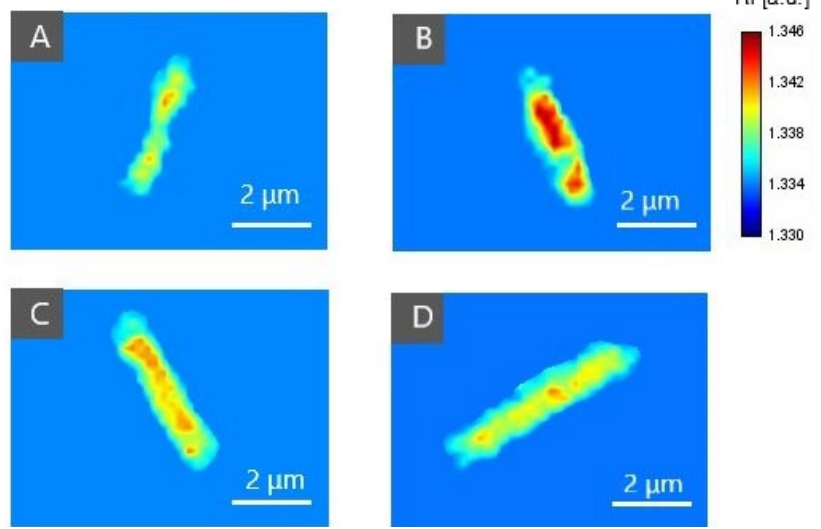
Figure 4. The representative 2D-RI maps of E. coli cells incubated without PS ( A ) and incubated with Ce6 + Pheo ( B ), Ce6 ( C ), or Pheo ( D ). Ce6 + Pheo ( B ), Ce6 ( C ), or Pheo ( D ).